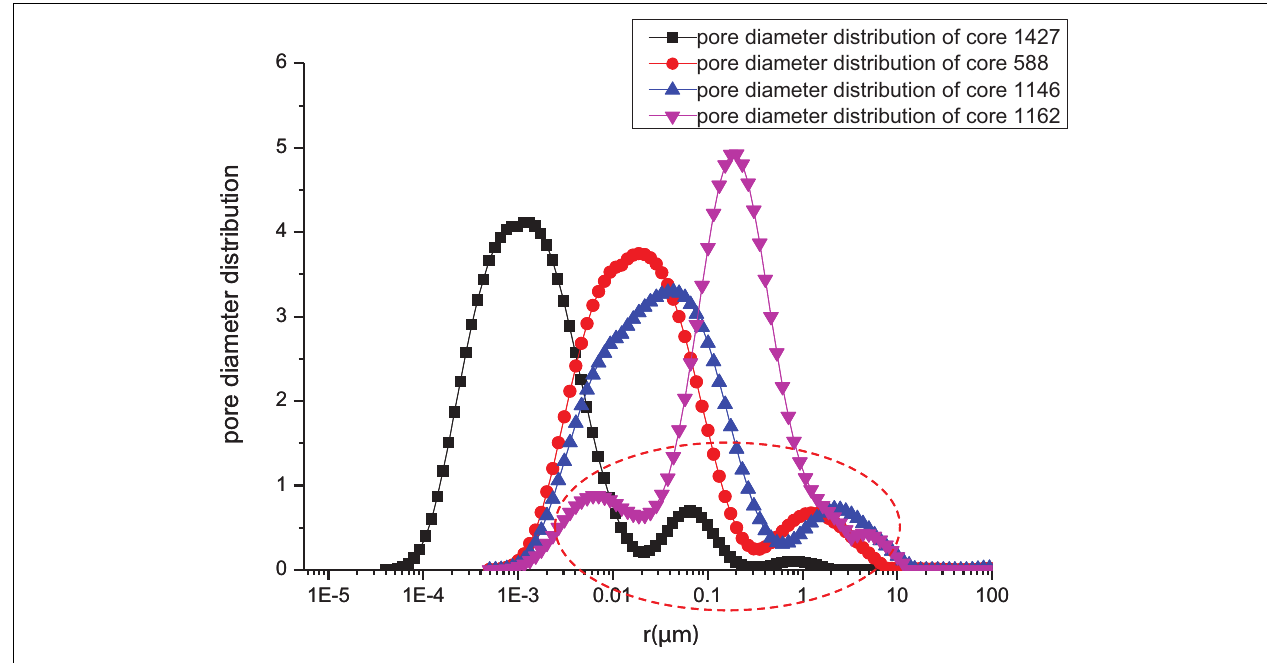
FIGURE 2 | Pore diameter distribution of the shale core from eastern Sichuan